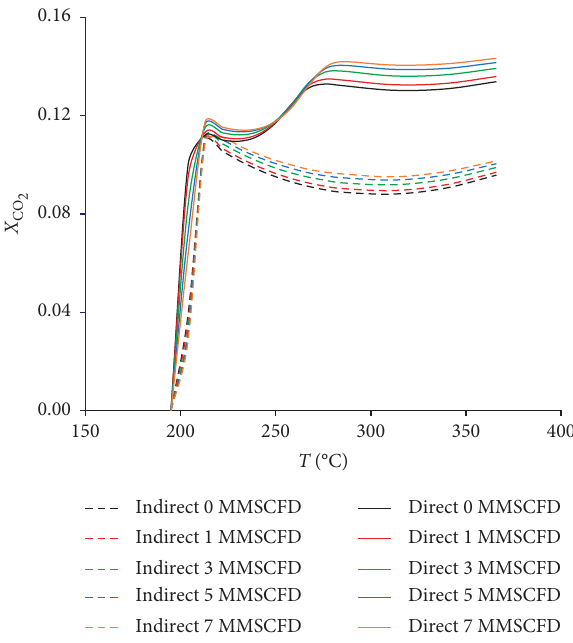
Figure 8: DME and methanol selectivity, S , as a function of the temperature of dual DME-methanol reactor at various unreacted gas recycle rates.